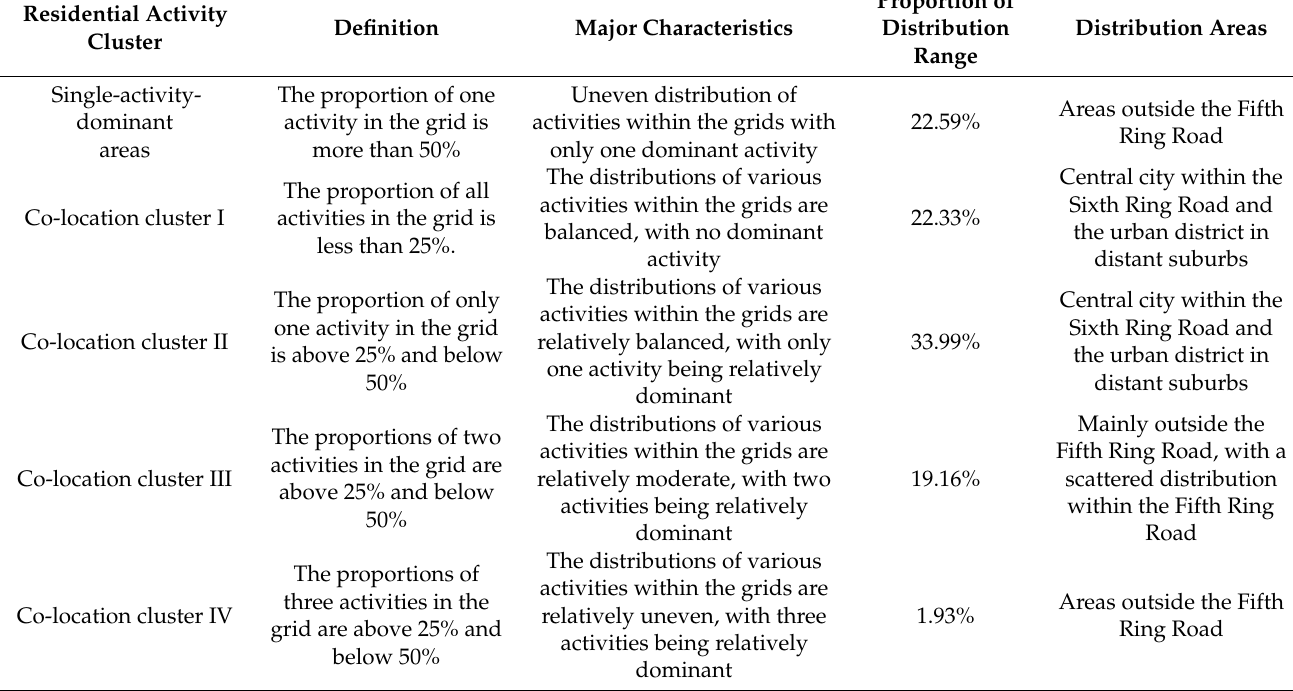
Table 7. The definitions of resident activity patterns and spatial distribution